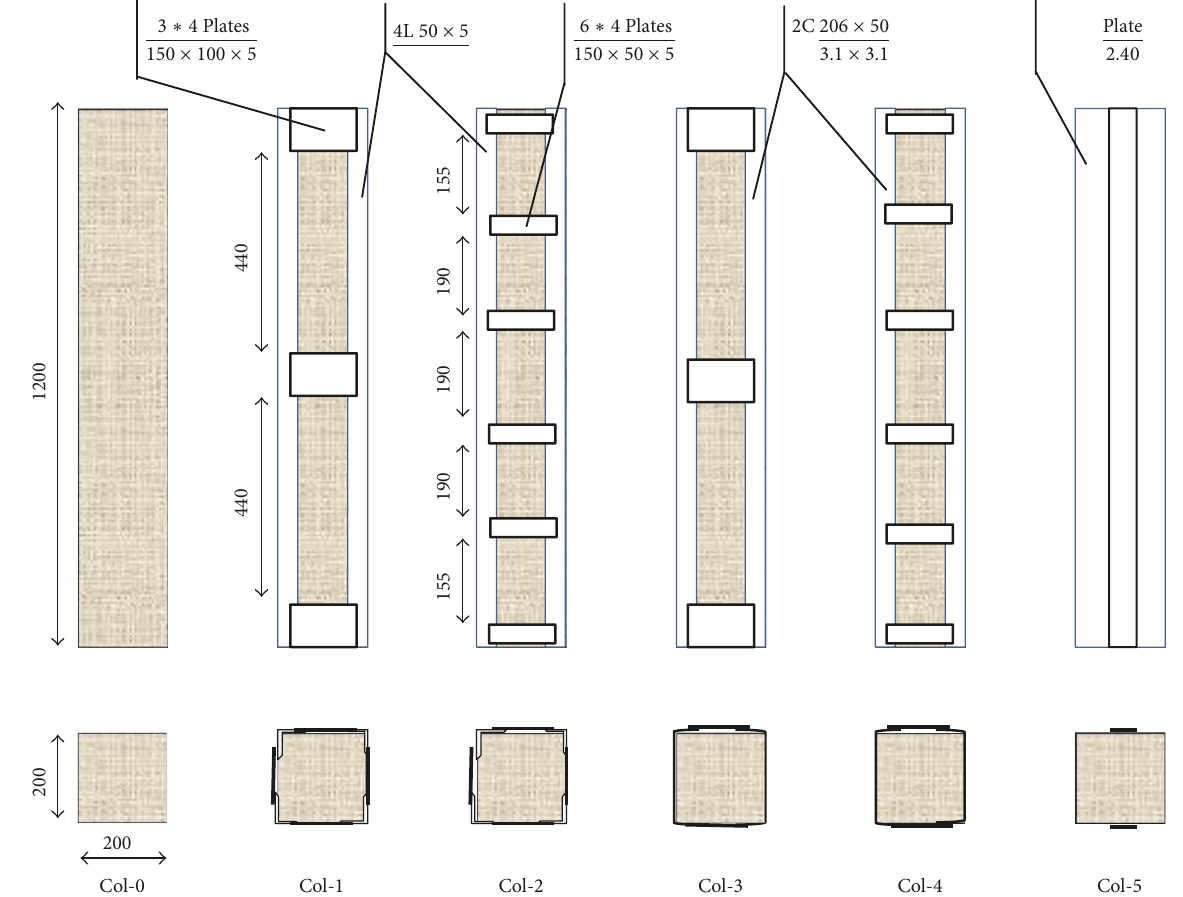
Figure 2: Details of dimensions and retrofitting configuration of columns